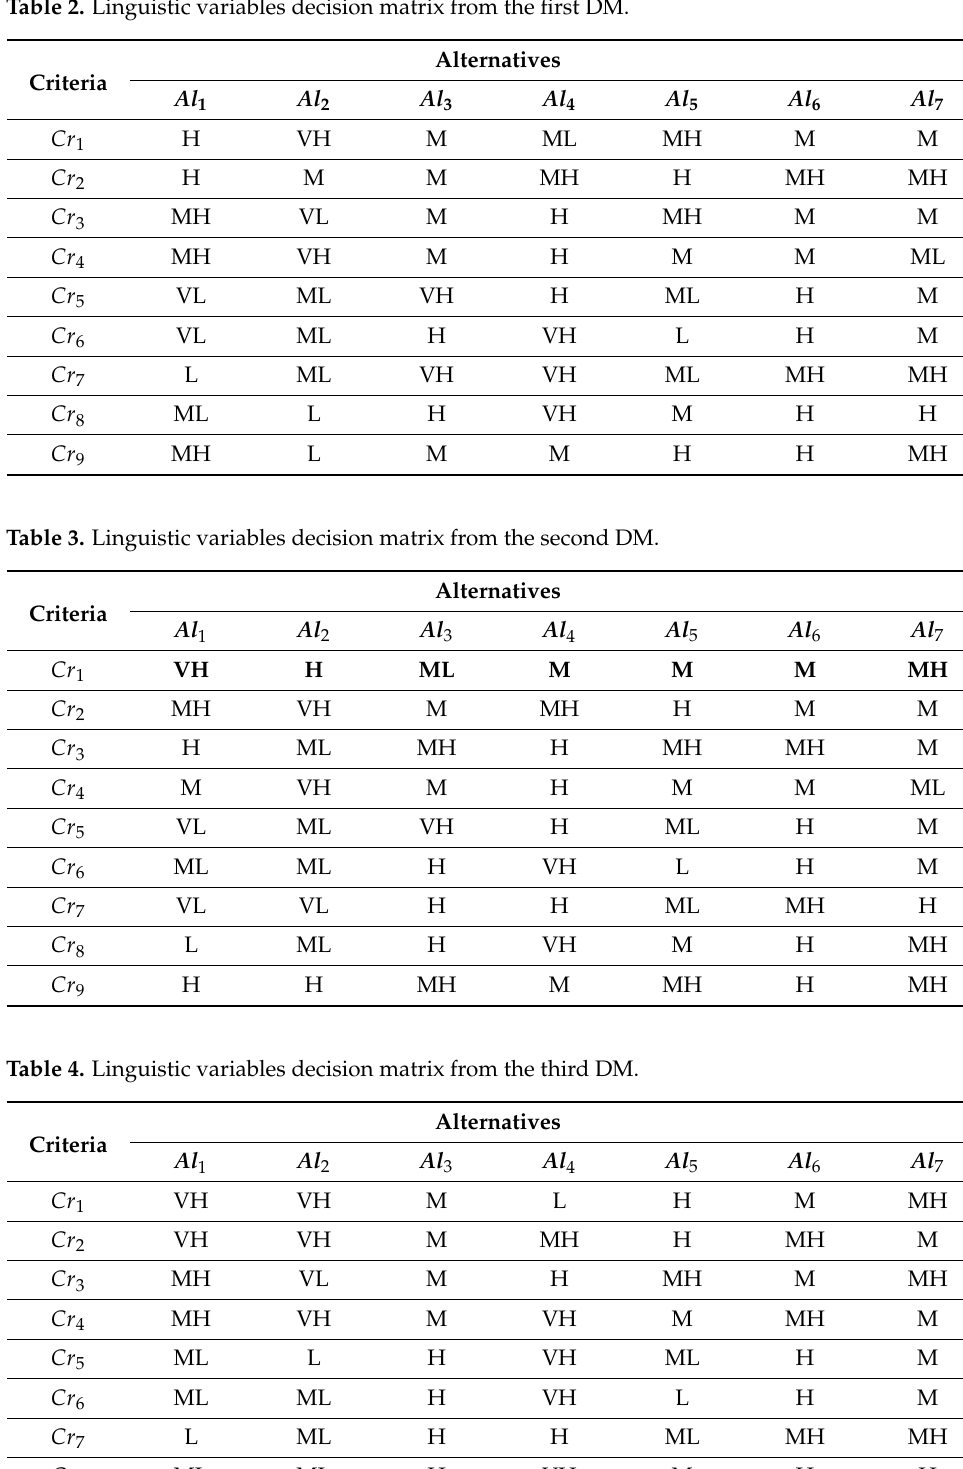
Table 2. Linguistic variables decision matrix from the first DM.